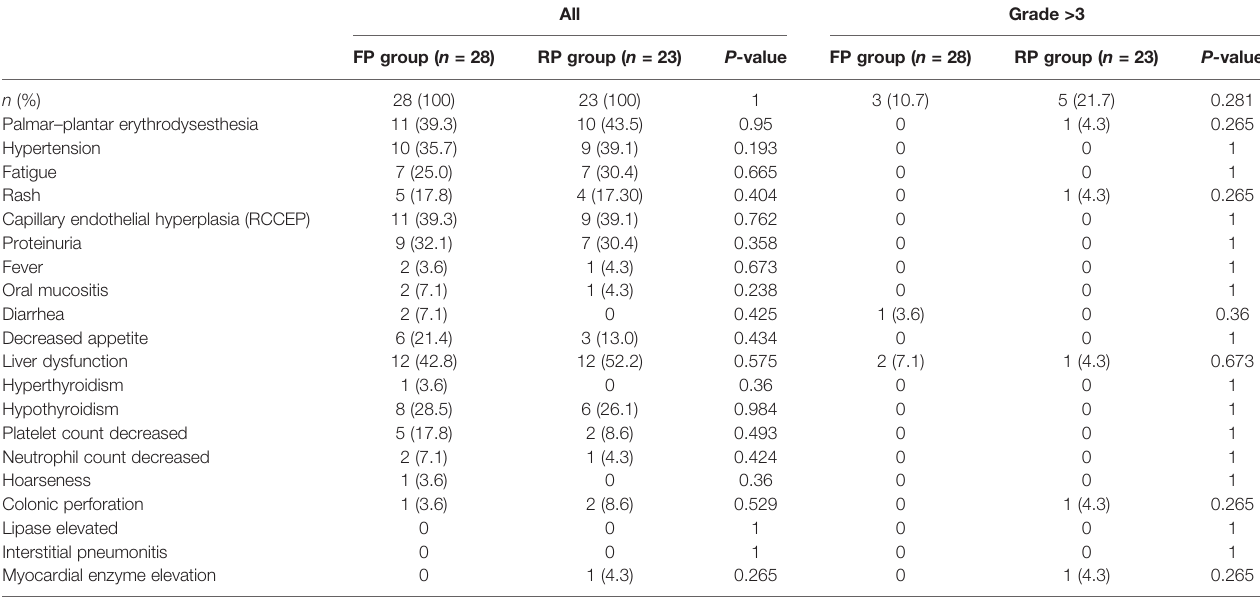
TABLE 3 | Adverse events.